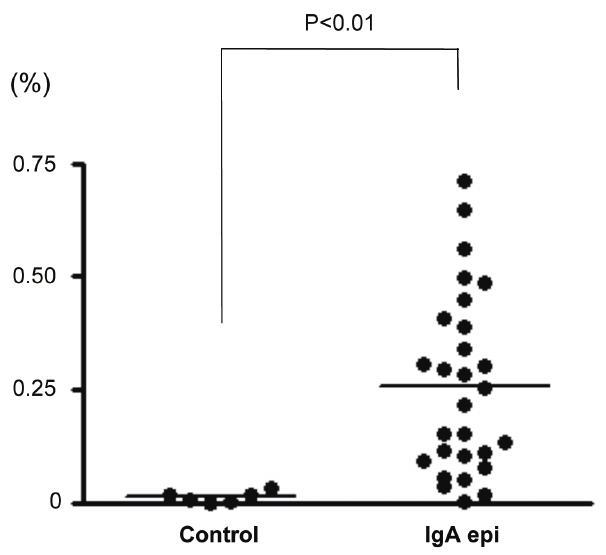
Figure 2. Gas6 stained area in human IgA nephropathy. Gas6 stained area is expressed as a percentage of total glomerular area occupied by Gas6 immunostained area. For each sample, at least eight glomerular profiles per patient were measured. IgA epi, IgA epithelial type.